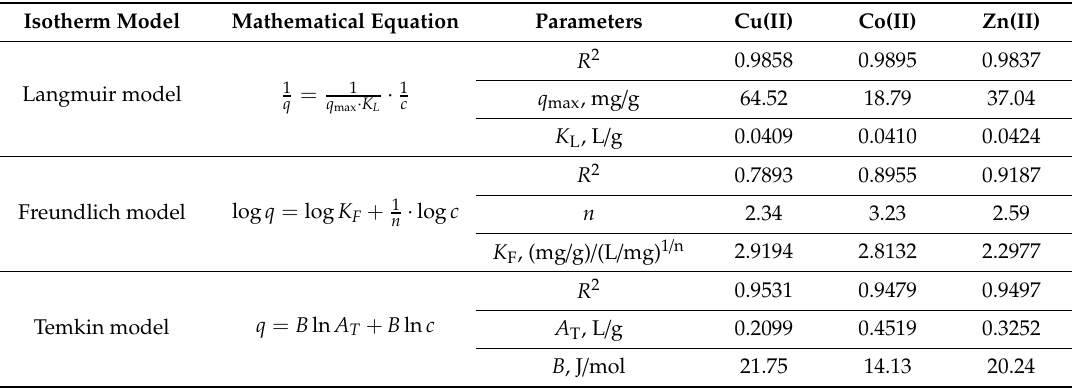
Table 2. Isotherm parameters calculated for the biosorption of Cu(II), Co(II) and Zn(II) ions on alginate. Isotherm Model